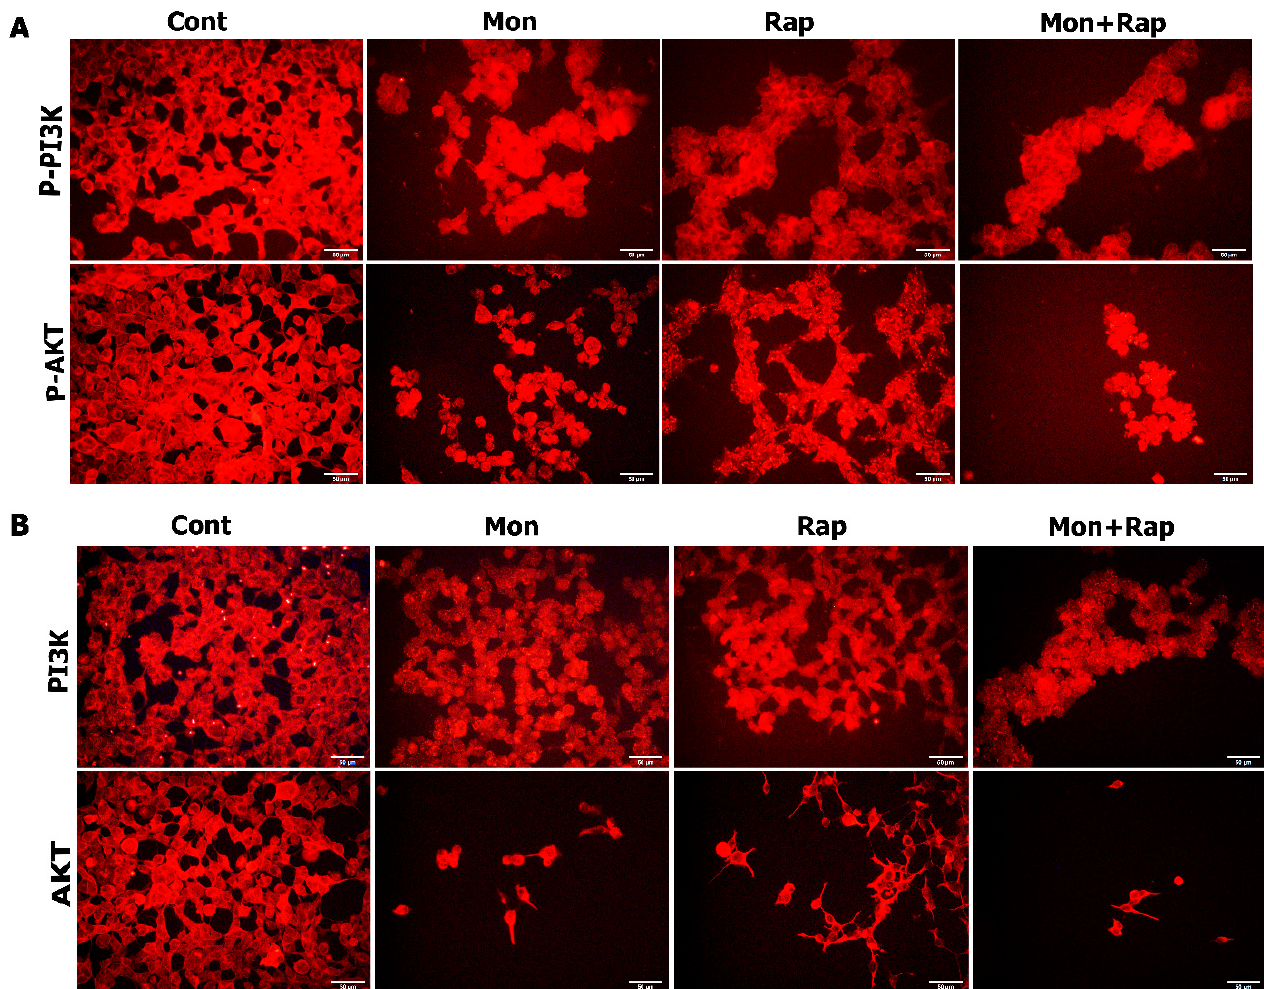
Figure 5. Evaluation of the effects of single and combined doses of mon and rap on the PI3K/AKT pathway using the immunofluorescence method. ( A ) Expressions of p-PI3K and p-AKT in different groups are labeled at the red fluorescent wavelength. ( B ) PI3K and AKT expressions in different groups are labeled at the red fluorescent wavelength. Bar: 50 µm.